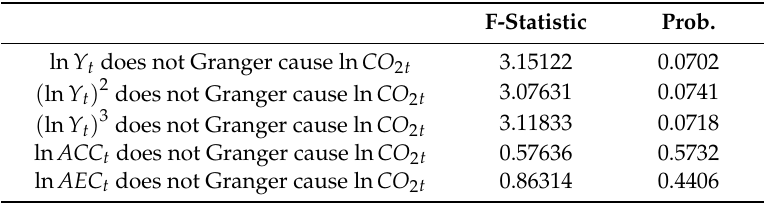
Figure 6. CUSUM and CUSUM of squares test for the squared model.